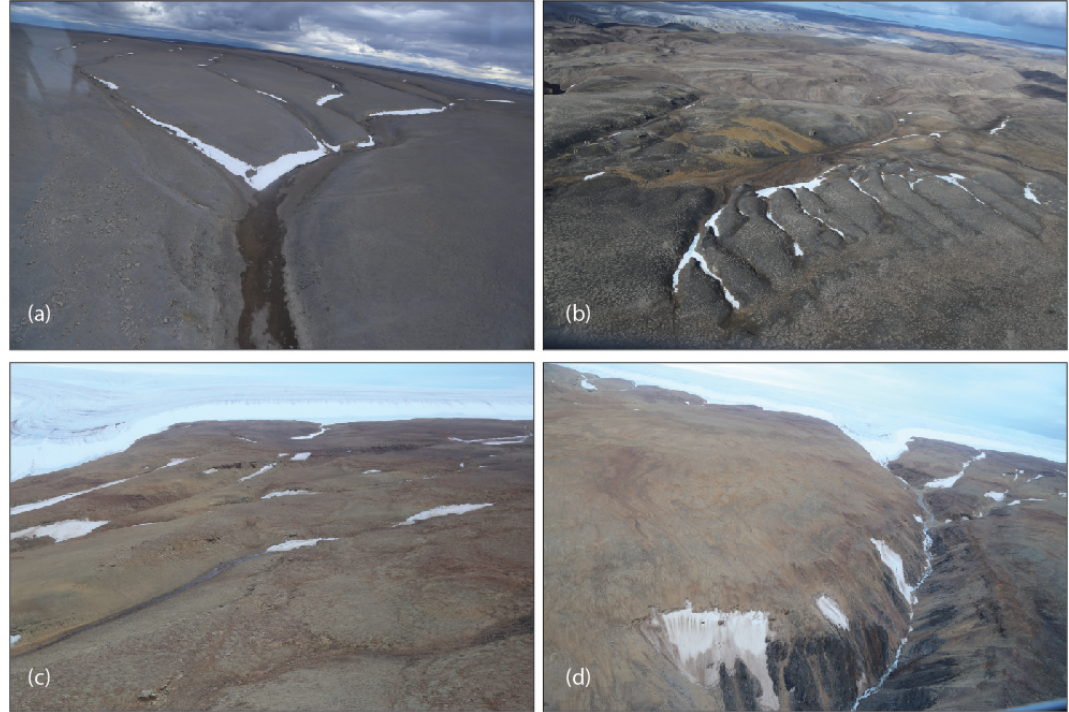
Figure 2. Aerial and field imagery of subglacial channels and rivers. (a) shows helicopter imagery of a group of subglacial channels (89.13 ◦ W, 75.28 ◦ N), channel widths approx. 35m. (b) shows a group of subglacial channels located at 89.37 ◦ W, 75.18 ◦ N, network is approx. 300m wide. (c) shows a subglacial channel emerging underneath the Devon Island ice cap; note the similar morphology to (a) and (b) , each channel being approx. 30m wide. (d) shows the cross section of a deeply incised canyon emerging from under the ice cap. Canyon cross section measures 200m